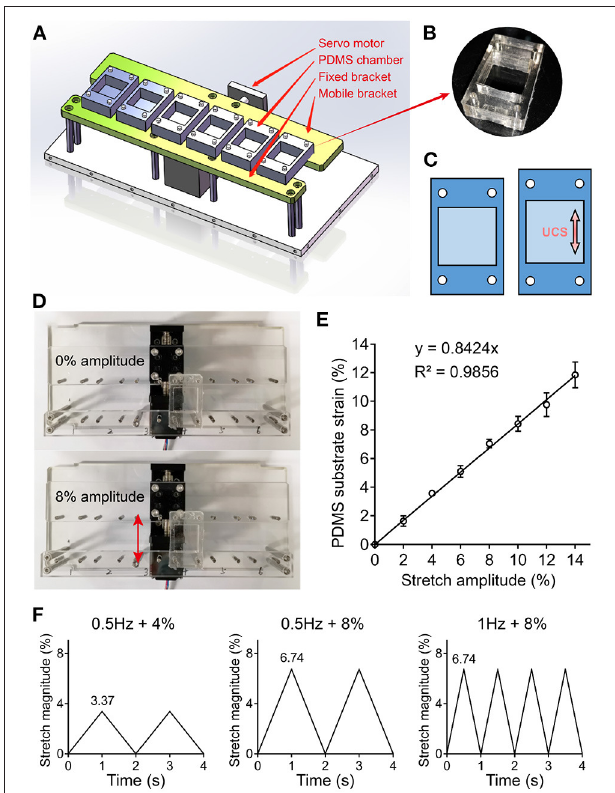
FIGURE 1 | (A) 3D drawing of an uniaxial cyclic stretchable homemade device with a servo motor, fixed and mobile bracket, and six elastic polydimethylsiloxane (PDMS) chambers. The device was driven by the servo motor that can load different frequencies and amplitudes of mechanical stimulation. (B) Photograph of PDMS chamber containing a 4 cm 2 cell culture area in the center. (C) Schematic illustration of PDMS substrate deformation. (D,E) Tensile testing analyses were performed to correlate stretch amplitude with PDMS substrate strain. Representative images (D) and data (E) of PDMS substrate deformation under different stretch amplitude are shown. (F) Three kinds of cyclic stretch with triangular wave pattern are shown. The 4 and 8% amplitude were servo motor set value, and the actual strain of PDMS substrate were 3.37 and 6.74%,